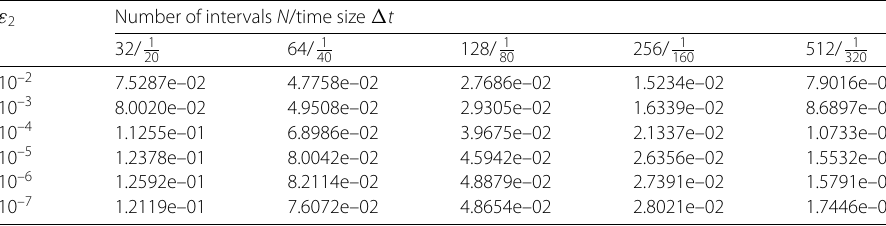
Table 6 Maximum error E N , M